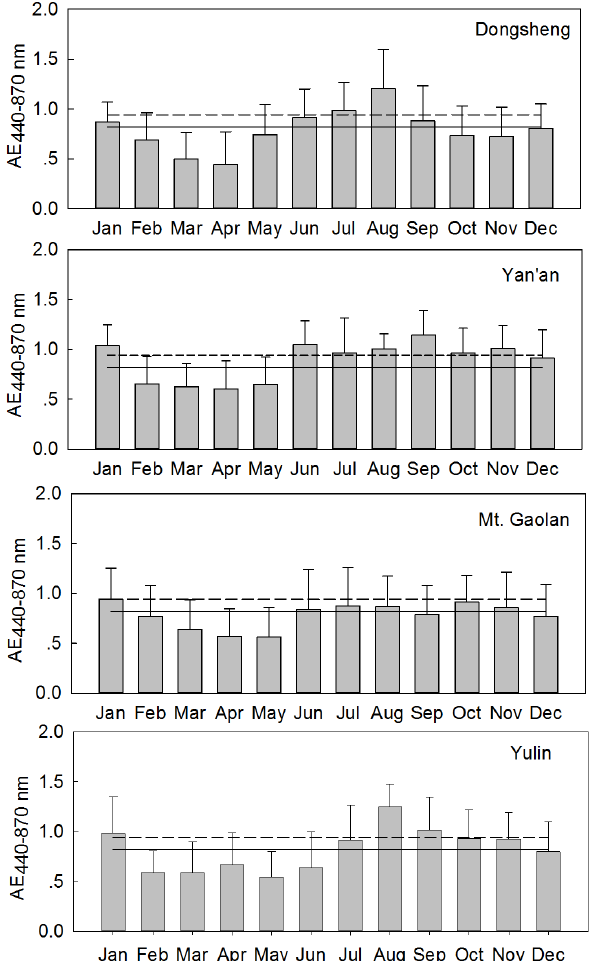
Figure 10. Monthly averaged AODs at 440nm at rural Loess Plateau sites. The solid and dash horizontal hairlines indicate the annual averages for the subgroup and the whole database, respec- tively.